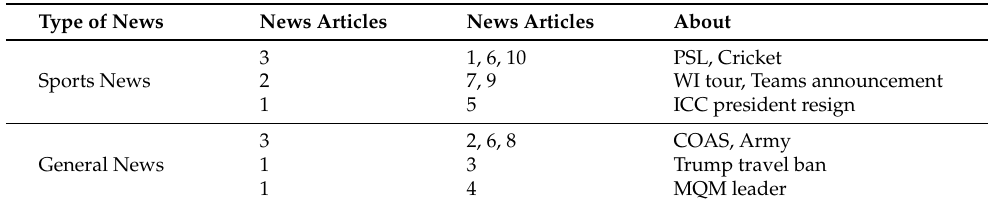
Table 4. Overview: 20 news article dataset in dual languages. Type of News